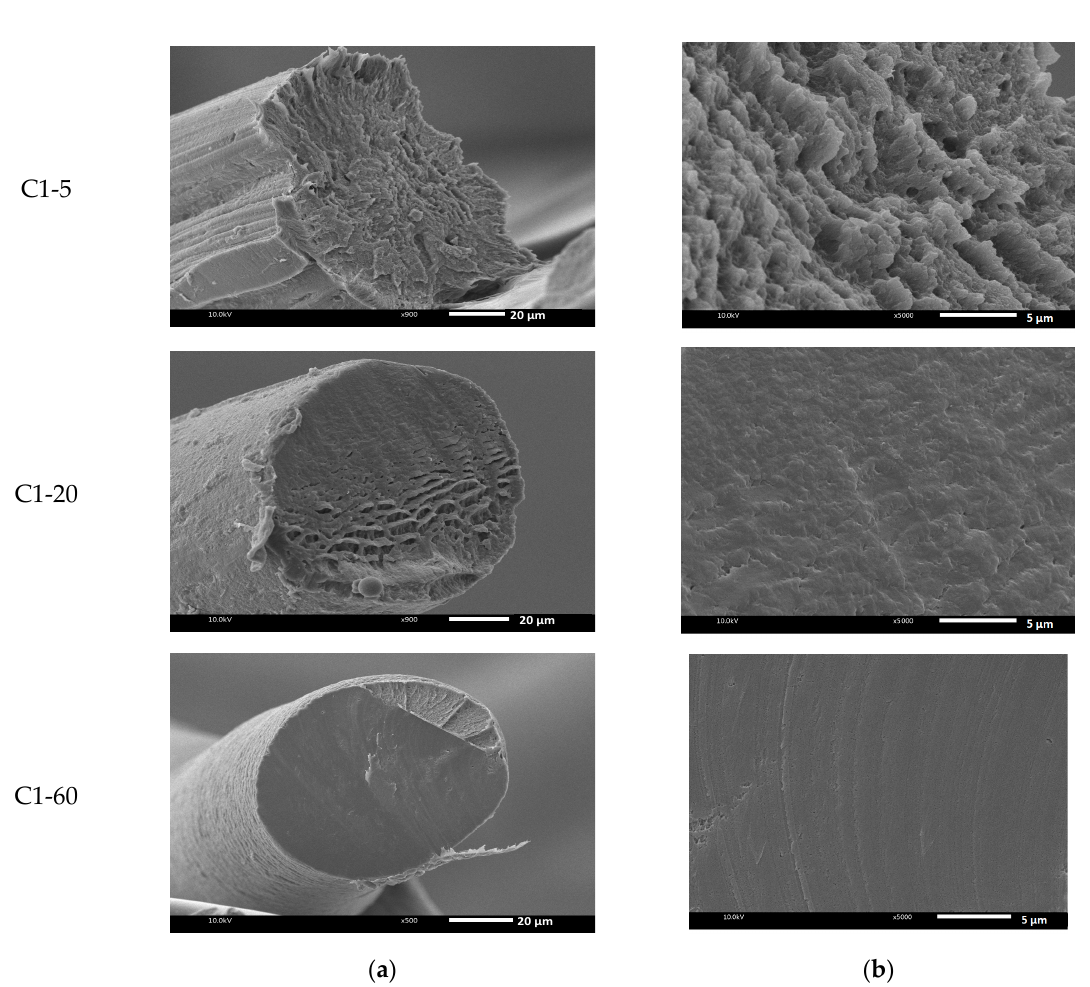
Figure 4. SEM images of the freeze-dried chitin fiber prepared at different temperatures of the coagulation bath at ( a ) 900 × and ( b ) 5000 ×.